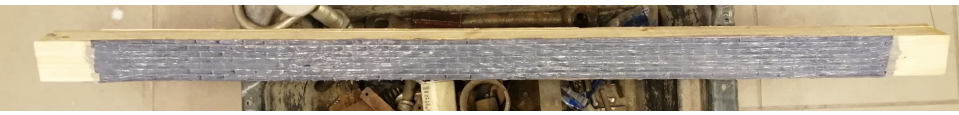
Figure 1. Reinforcing specimens with CFRP